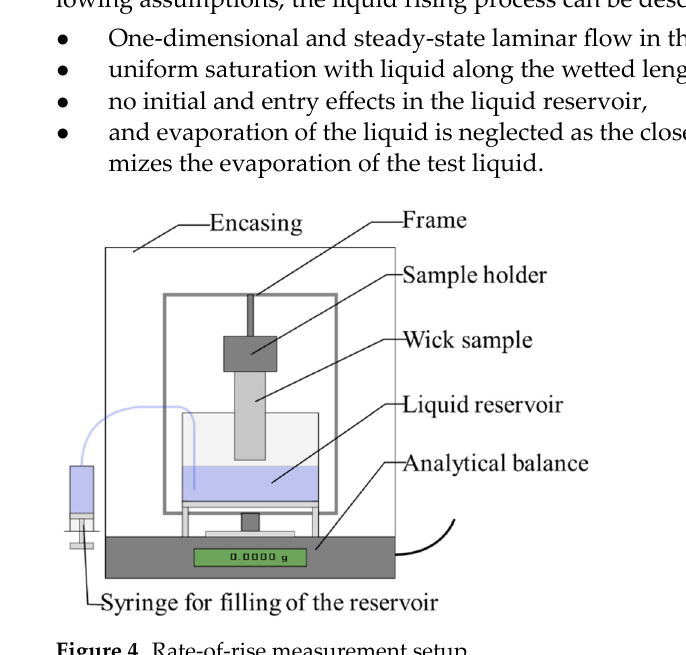
Figure 4. Rate-of-rise measurement setup. Figure 4. Rate‑of‑rise measurement